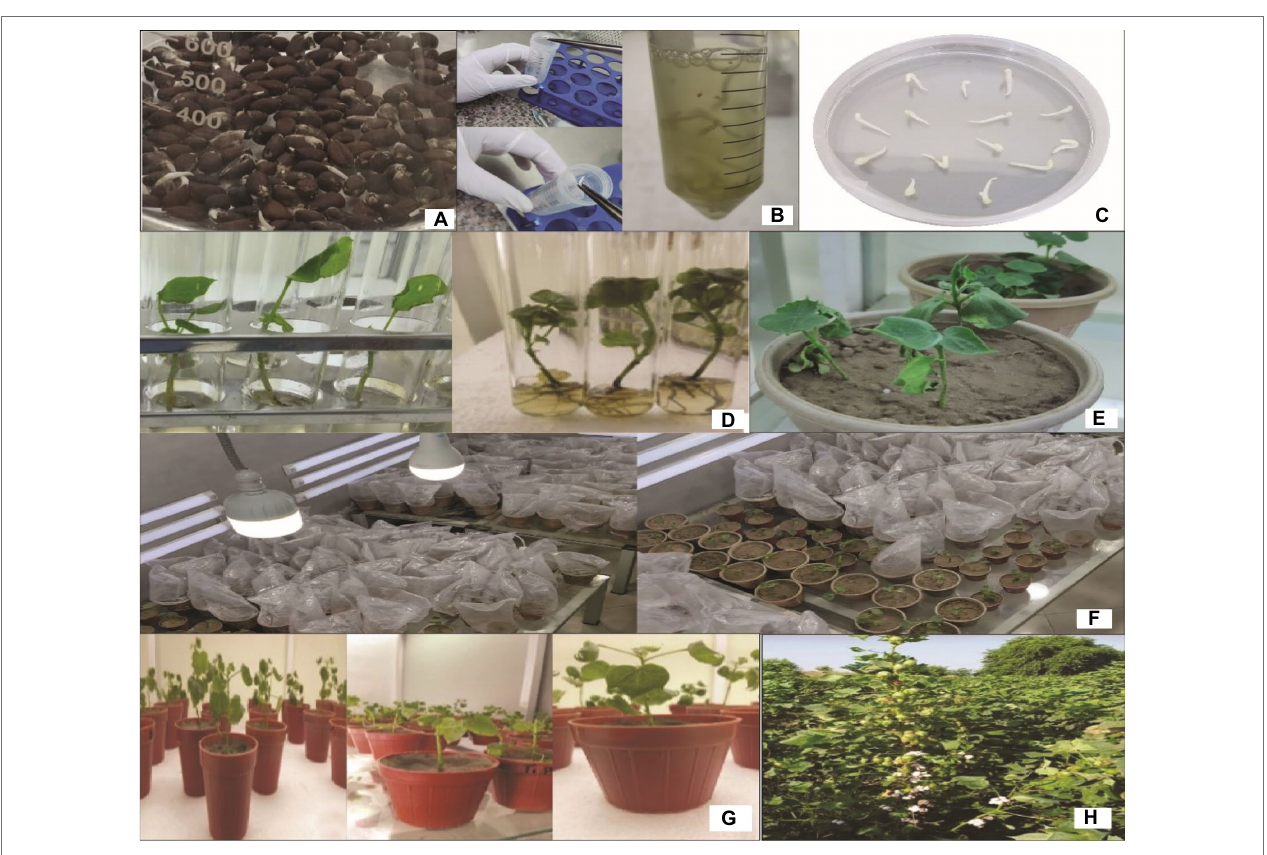
FIGURE 6 | A schematic procedure of Gh_A07G1537 gene transformation in cotton; (A,B) soaking of seeds, (C) shifting of embryos on MS plates, (D) shifting of embryos into the MS tubes, (E–G) shifting of plants into the pots, and (H) shifting of plants into the field.